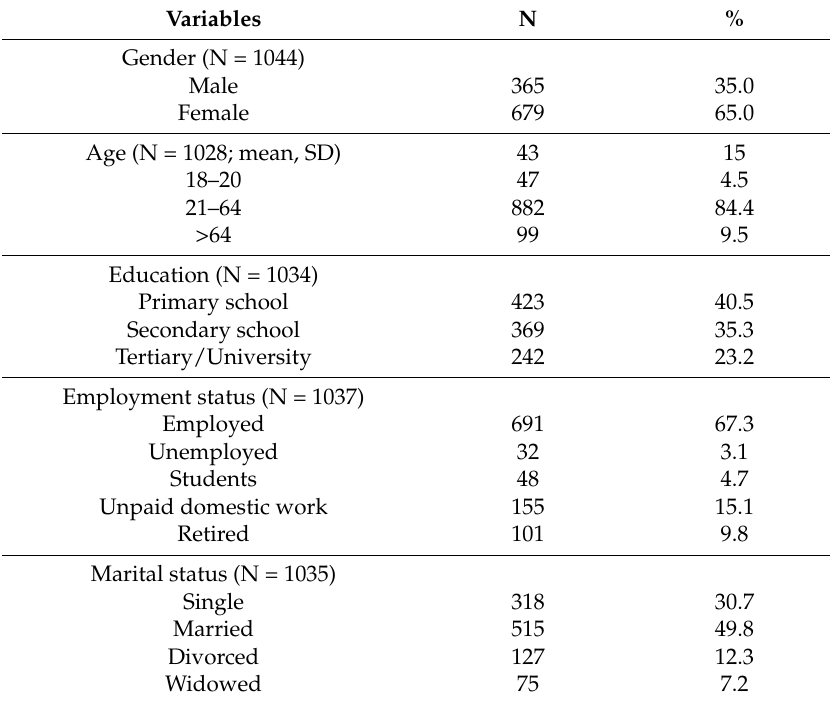
Table 1. Baseline characteristics of the